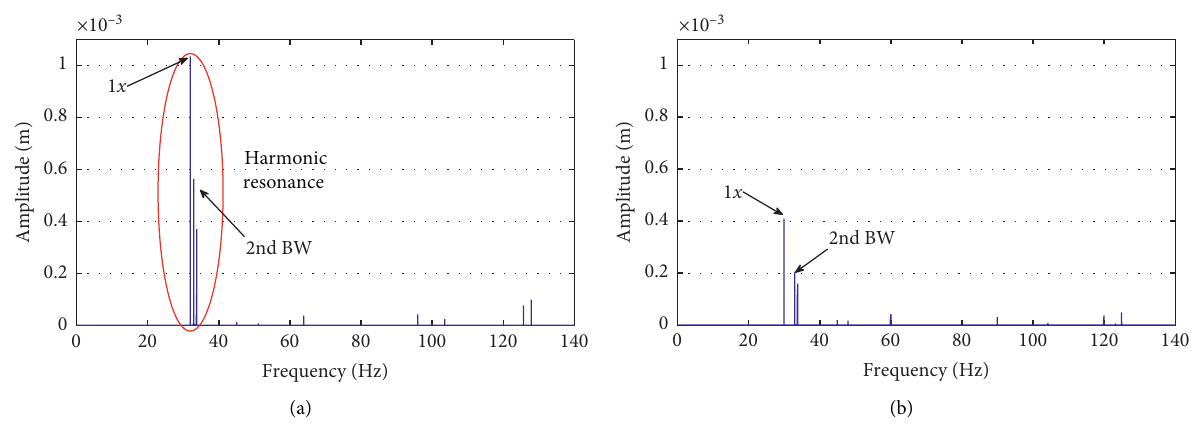
Figure 17: Resonance of 1 x in the vertical direction of bearing 1: (a) 32 Hz and (b) 30